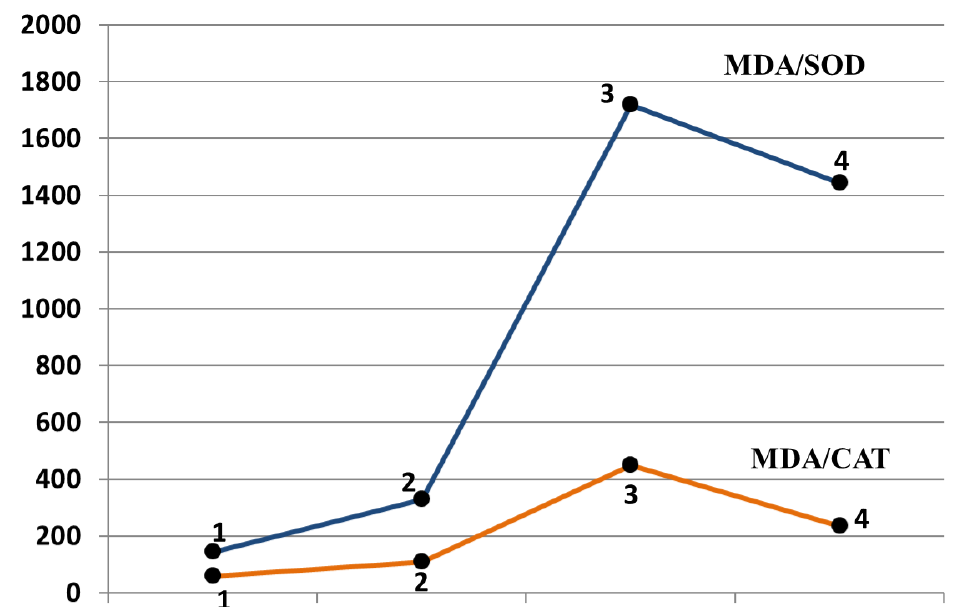
Figure 3. Concentration ratios of malonic dialdehyde to superoxide dismutase and malonic dialdehyde to catalase in the blood plasma of patients with atrophic gastritis and gastric cancer. 1—Group A; 2—Group B; 3—Group C; 4—Group D. The significance of differences was assessed by the Kruskal–